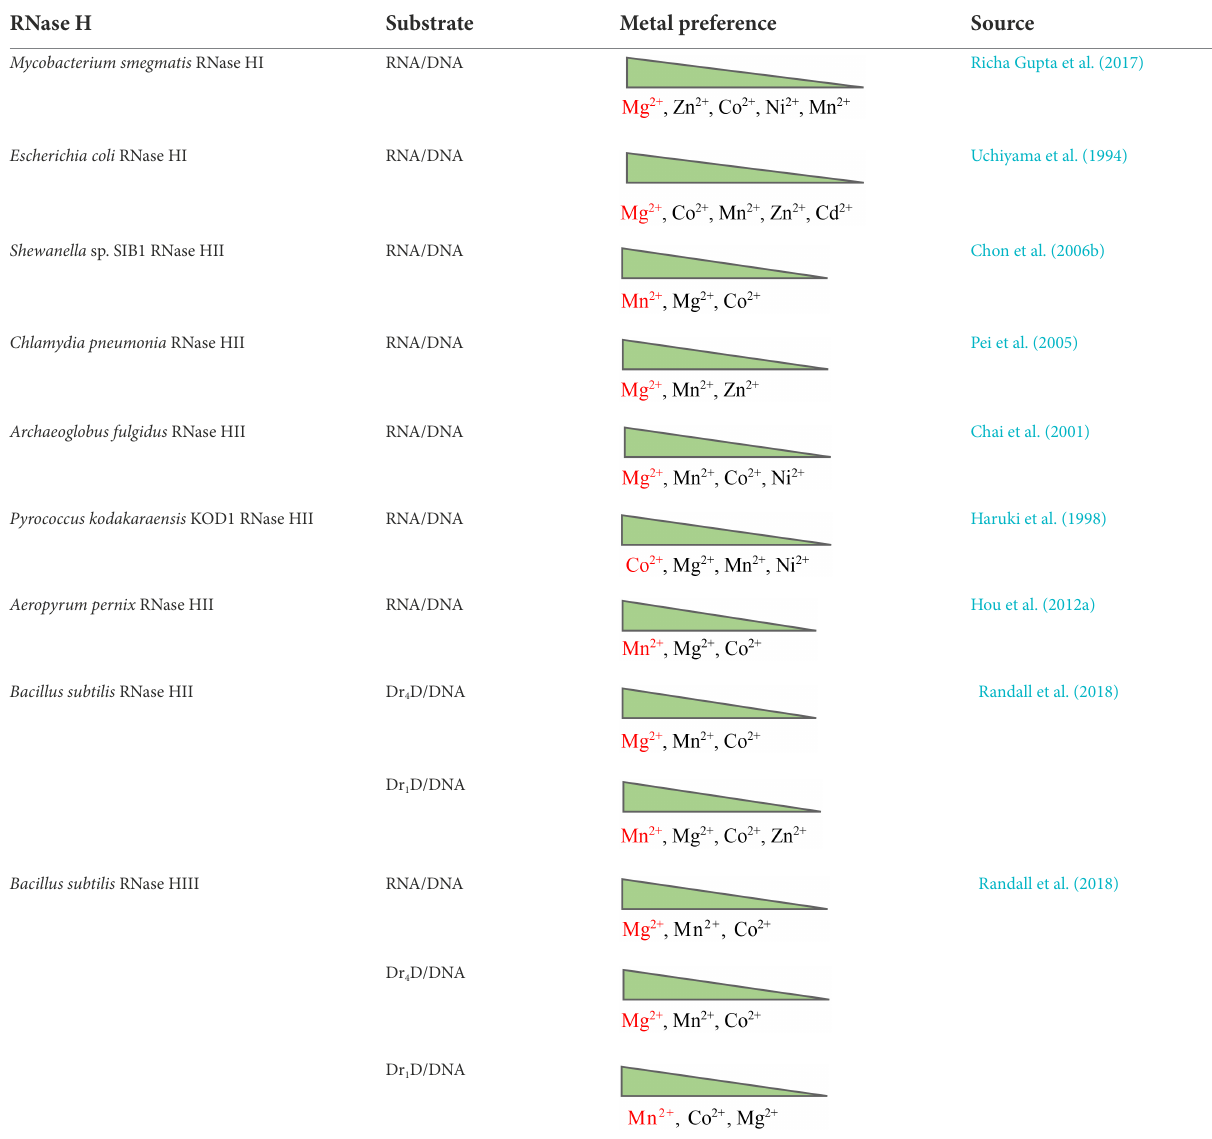
TABLE 1 Metal choices of RNases H. RNase